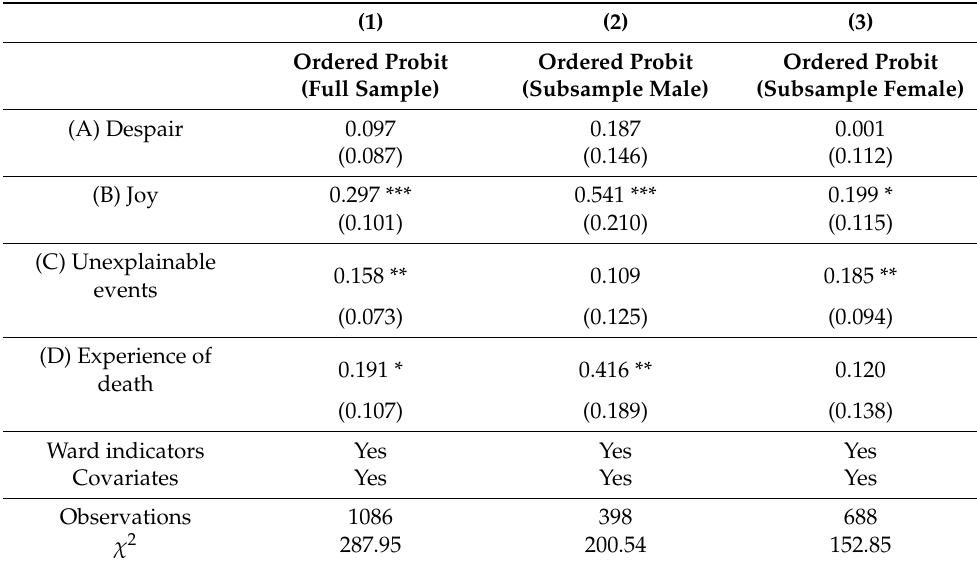
Table 10. Estimation results regressing labor market status on contingency